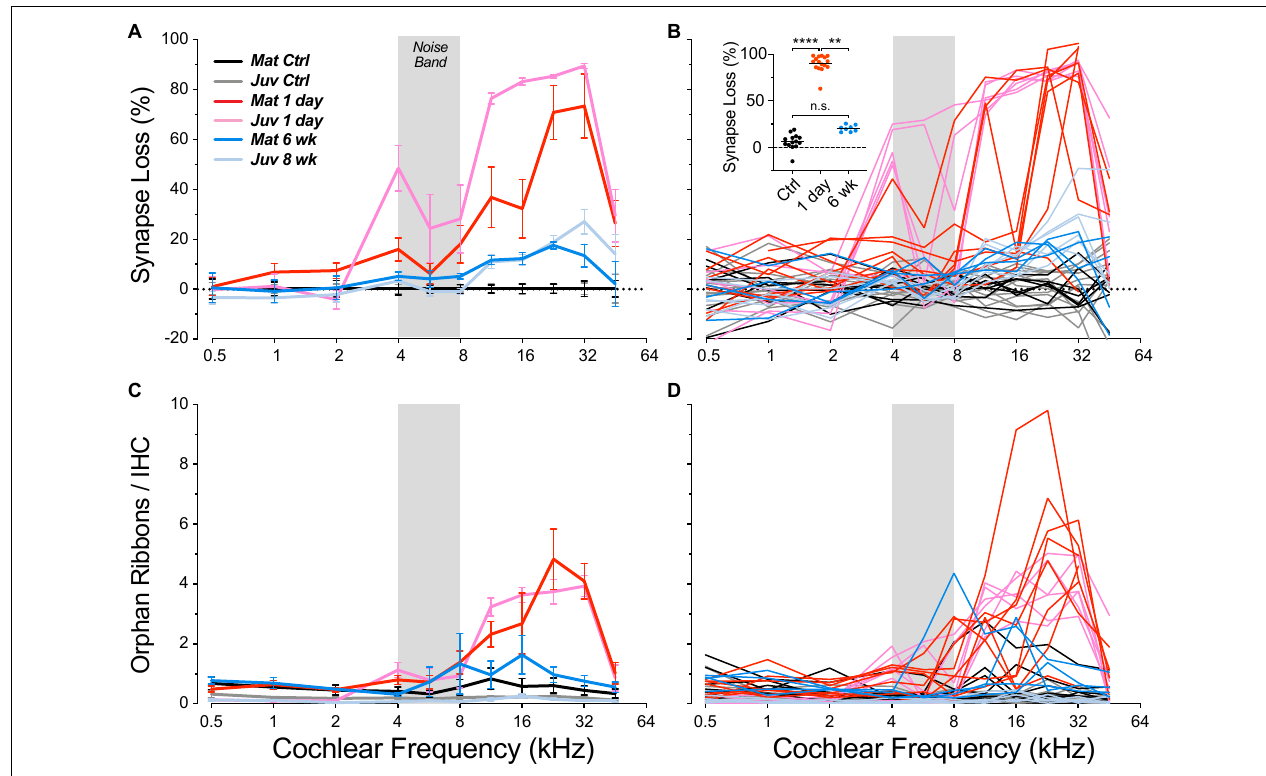
FIGURE 7 | Post-exposure synapse loss and recovery are similar in juvenile and mature ears, although the acute loss is smaller in the mature cases. Panels (A,B) show loss of synapses, i.e., closely apposed CtBP2/GluA2 puncta, expressed re mean values from the appropriate unexposed control group. Panels (C,D) show orphan ribbon counts per IHC, i.e., CtBP2 puncta unpaired with a post-synaptic GluA2 patch. Data are shown for individual animals (B,D) and as group means ± SEMs (A,C) . Data from juvenile animals are from a prior study (Hickman et al., 2020). Group sizes were: mature control, n = 7 ears of 4 animals; juvenile control, n = 13 ears of 7 animals; mature 1 day, n = 8 ears of 5 animals; juvenile 1 day, n = 6 ears of 3 animals; mature 6 week, n = 4 ears of 2 animals; and juvenile 8 weeks, n = 6 ears of 3 animals. The inset to (B) shows the synaptic loss for each z-stack sampled in each mature ear at its region of peak loss. **** p < 0.0001 and ** p = 0.003 by Dunnett’s T3 multiple comparisons test, comparing peak synaptopathy per